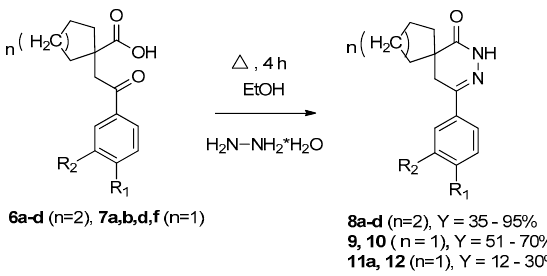
Scheme 4. Ring closure with hydrazine.